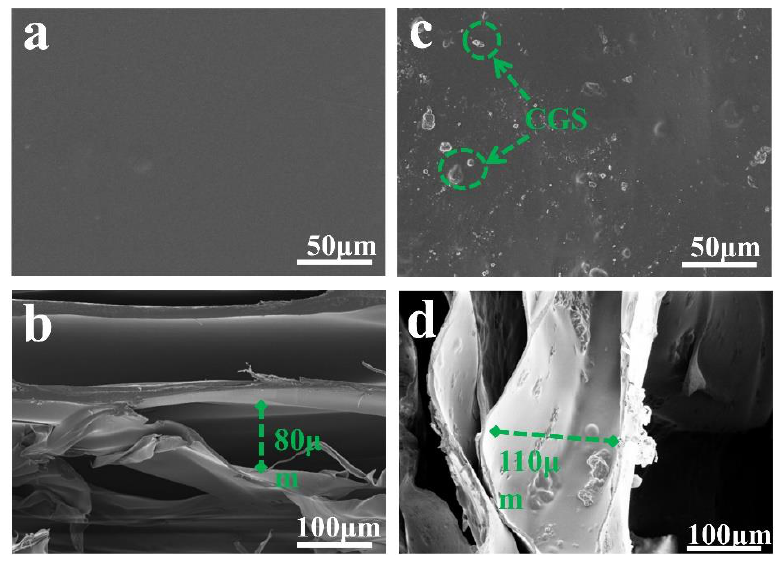
Figure 7. ( a ) The surface of F-0, ( b ) the interior of F-0, ( c ) the surface of F-0.3, and ( d ) the interior of F-0.3.